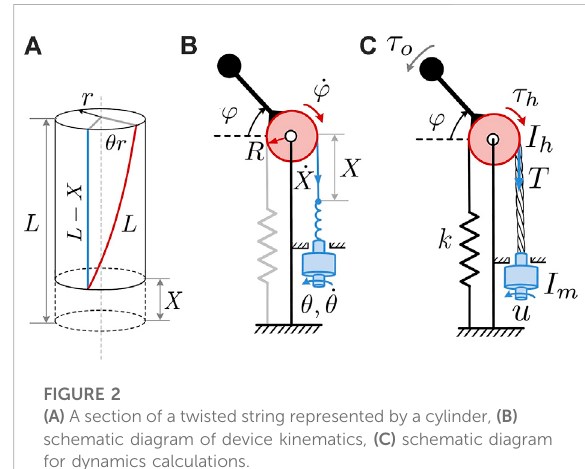
(A) A section of a twisted string represented by a cylinder, (B) schematic diagram of device kinematics, (C) schematic diagram for dynamics